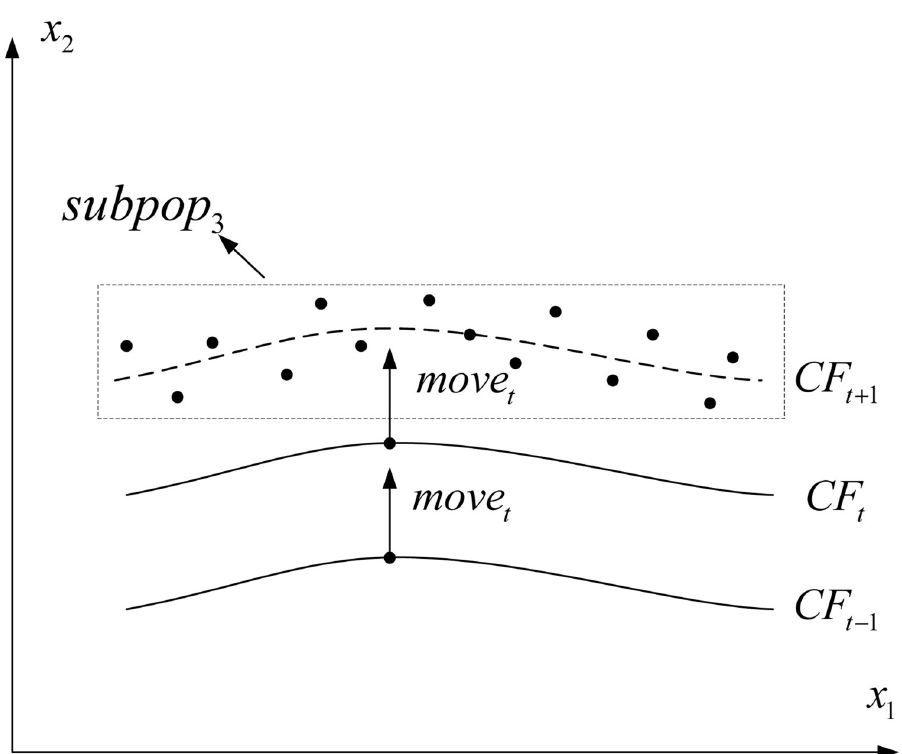
Fig 2. Illustration of curve fitting-based